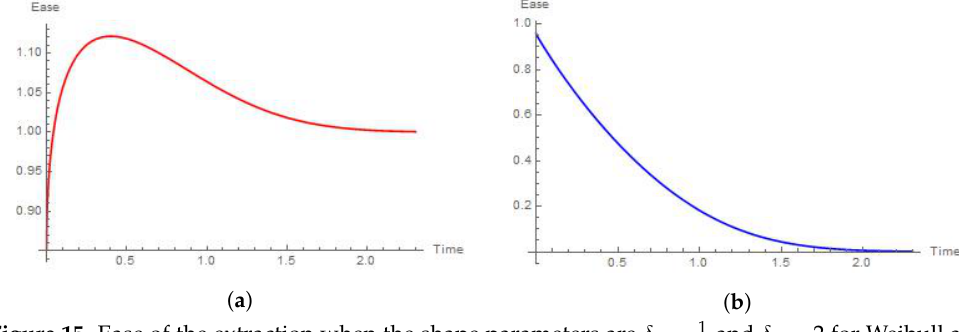
and δ 2 = 2 for Weibull and 2 . ( b ) Ease 2